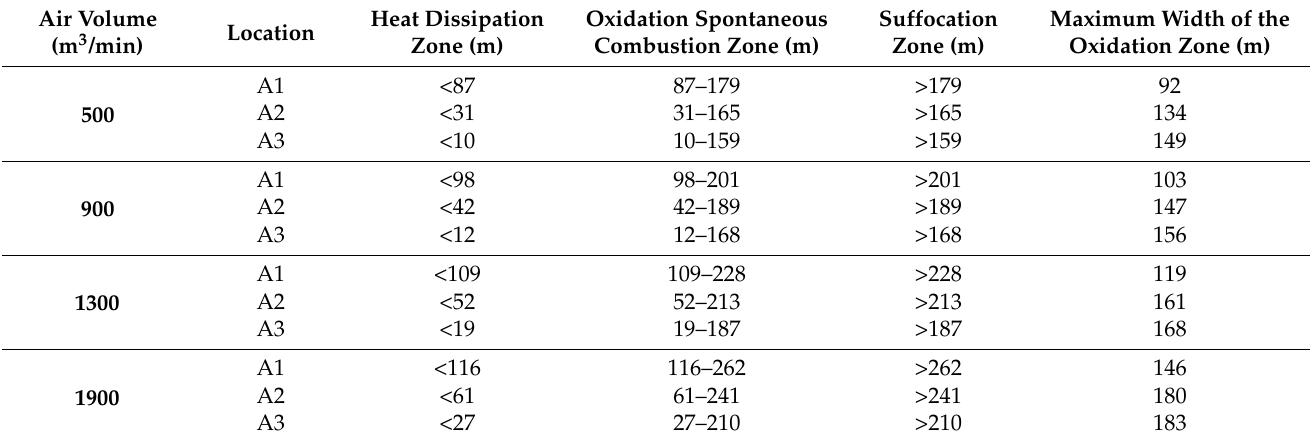
Table 4. Distribution of three zones of goaf during air volume regulation.